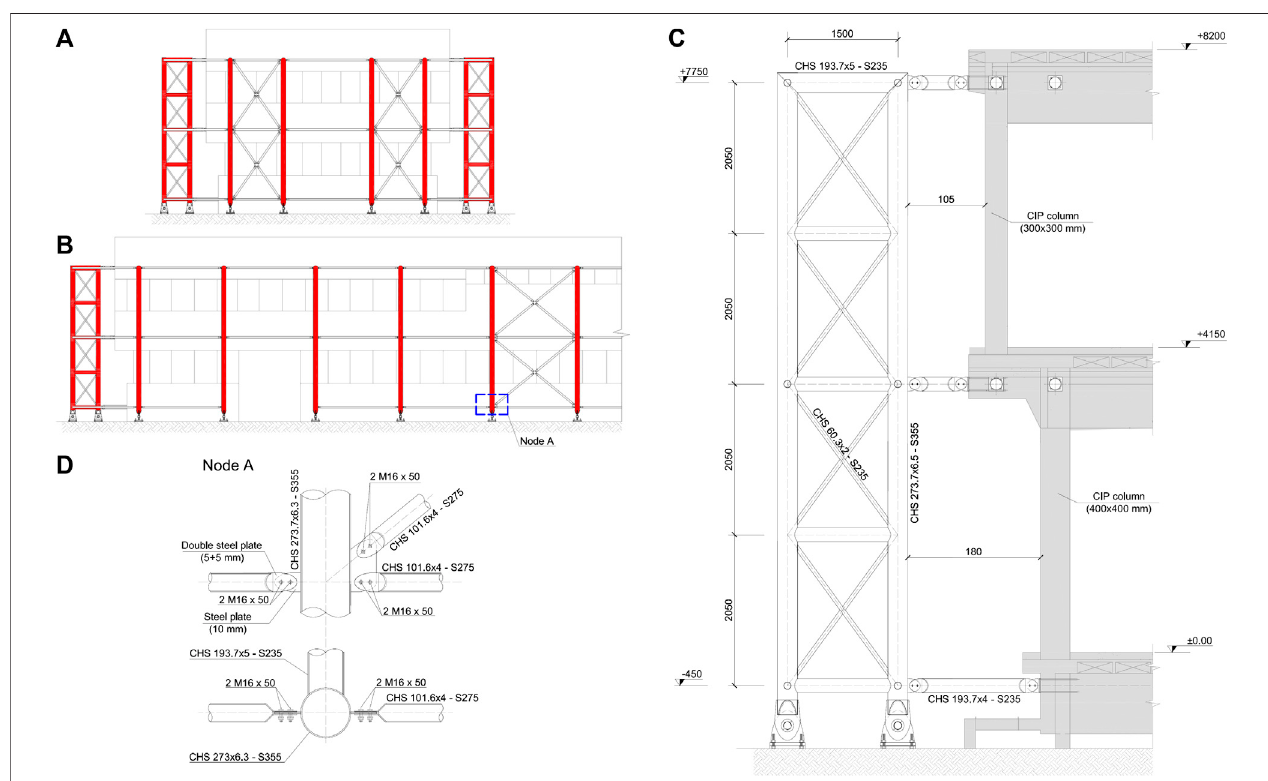
FIGURE 9 | Spatial steel bracing system applied to a two-storey building: (A),(B) building front views; (C) lateral view of one of the truss frames of the bracing system comprised of circular hollow section pro fi les and (D) detail view of a node. Dimensions in mm.